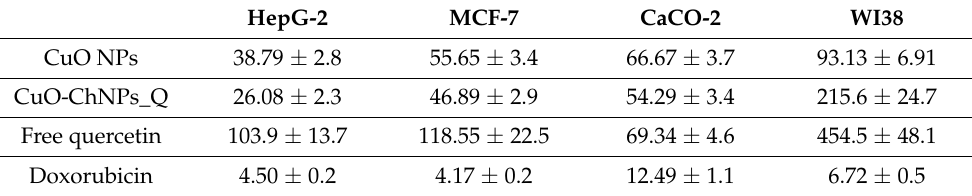
Table 3. IC50 values in µ g/mL—adapted from Table 2 of Elsayed et al. [105] with permission. HepG-2 MCF-7 CaCO-2